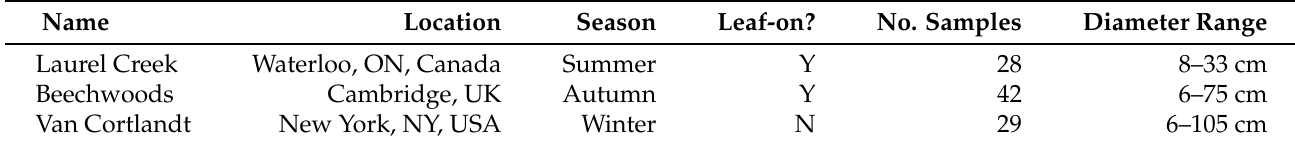
Table 1. Summary of evaluation data